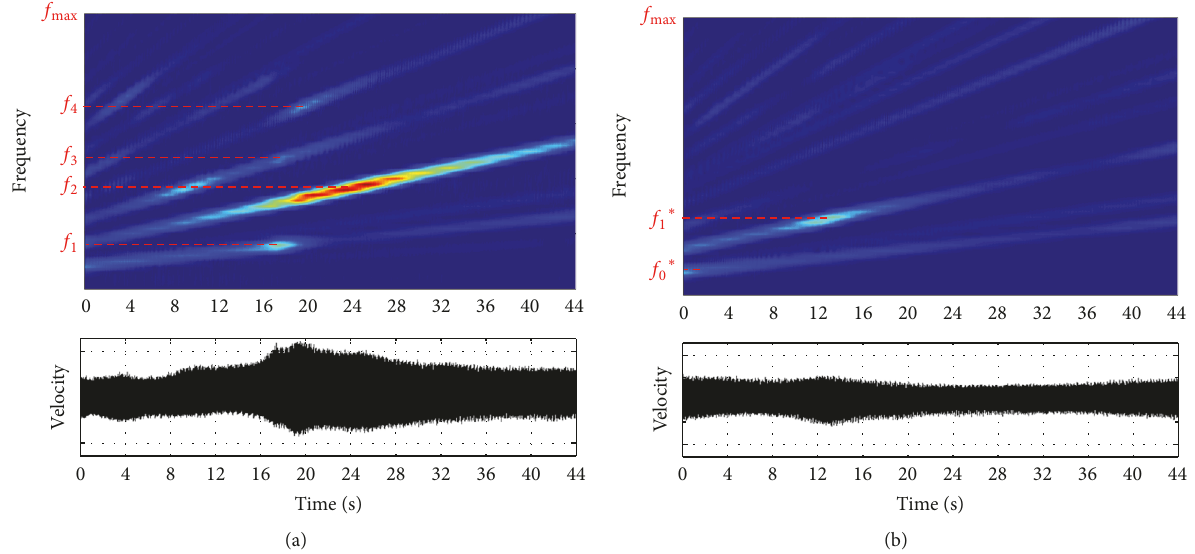
Figure 8: Time-frequency analysis of the relative velocity 𝑛 rel computed for a run-up test: (a) 45 Sh rubber elements and (b) 70 Sh rubber elements.